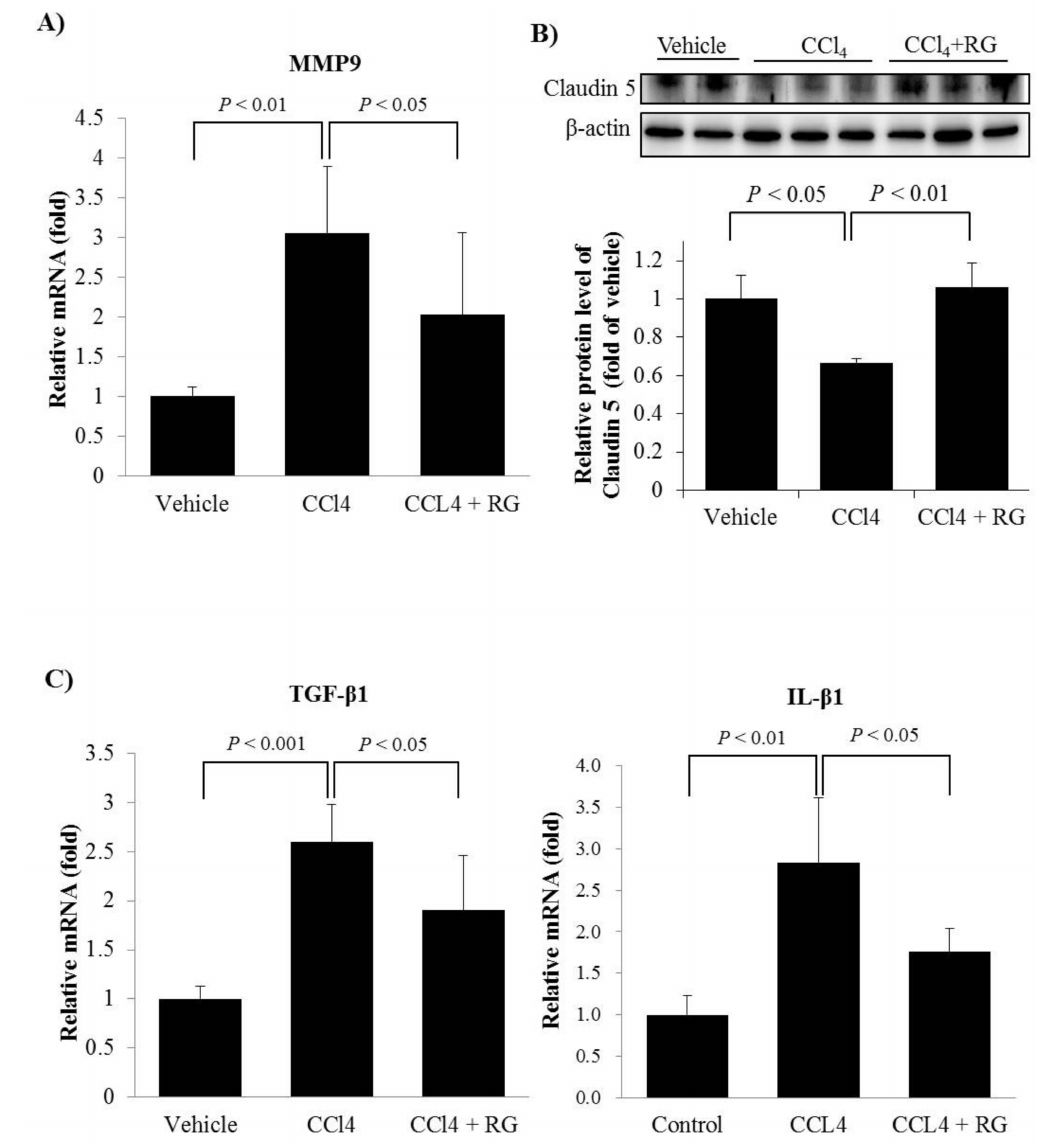
Figure 5. RG suppresses BBB disruption and inflammation in mice with CCl4-induced HE. Mice were treated with CCl 4 , and RG as described in Figure 3. RT-qPCR analysis of the mRNA expression levels of ( A ) MMP-9, ( C ) TGF- β 1, and ( D ) IL-1 β . ( B ) The protein levels of claudin-5 were assessed by western blot, in which β -actin served as a loading control. Protein levels were presented as relative band intensities to control (vehicle treated) group. Data were represented by mean ±